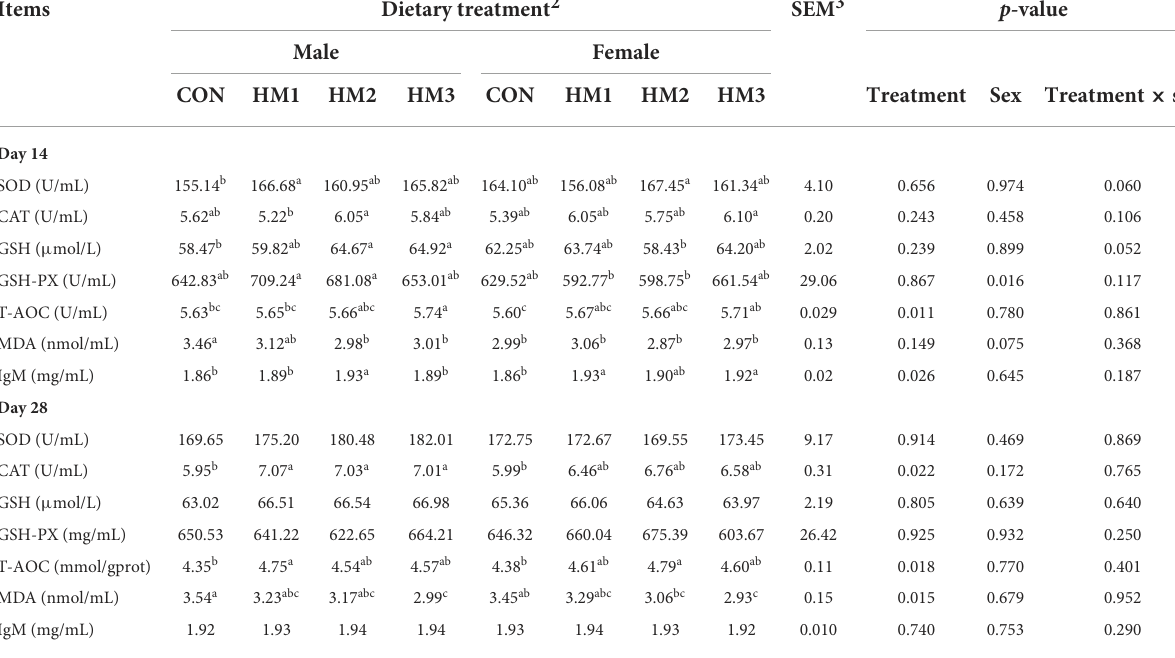
TABLE 2 Effects of herbal mixture on antioxidant indicators and IgM concentrations in serum of weaned pigs 1 . Items Dietary treatment 2 SEM 3 p -value Male Female CON HM1 HM2 CON